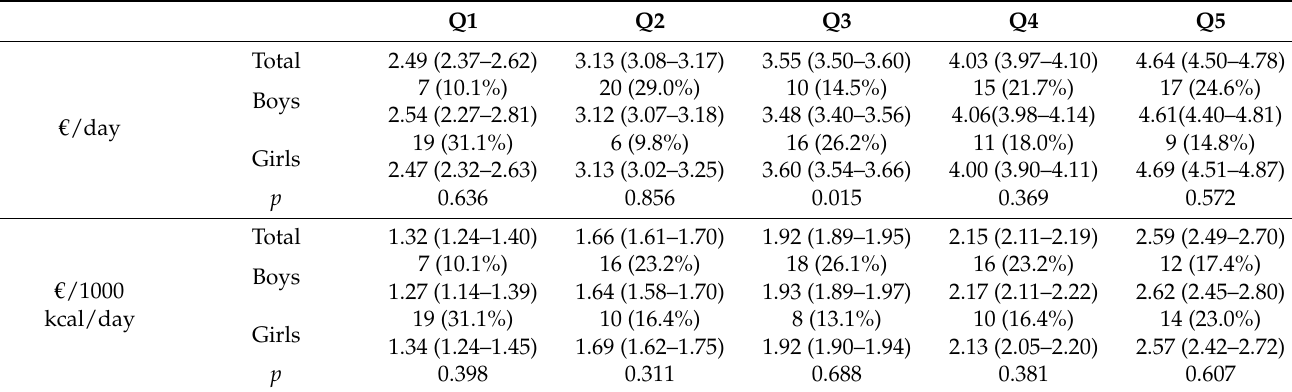
Table 2. Distribution of schoolchildren across quintiles of daily monetary diet cost ( € /day and € /1000 kcal/day). Q1 Q2 Q3